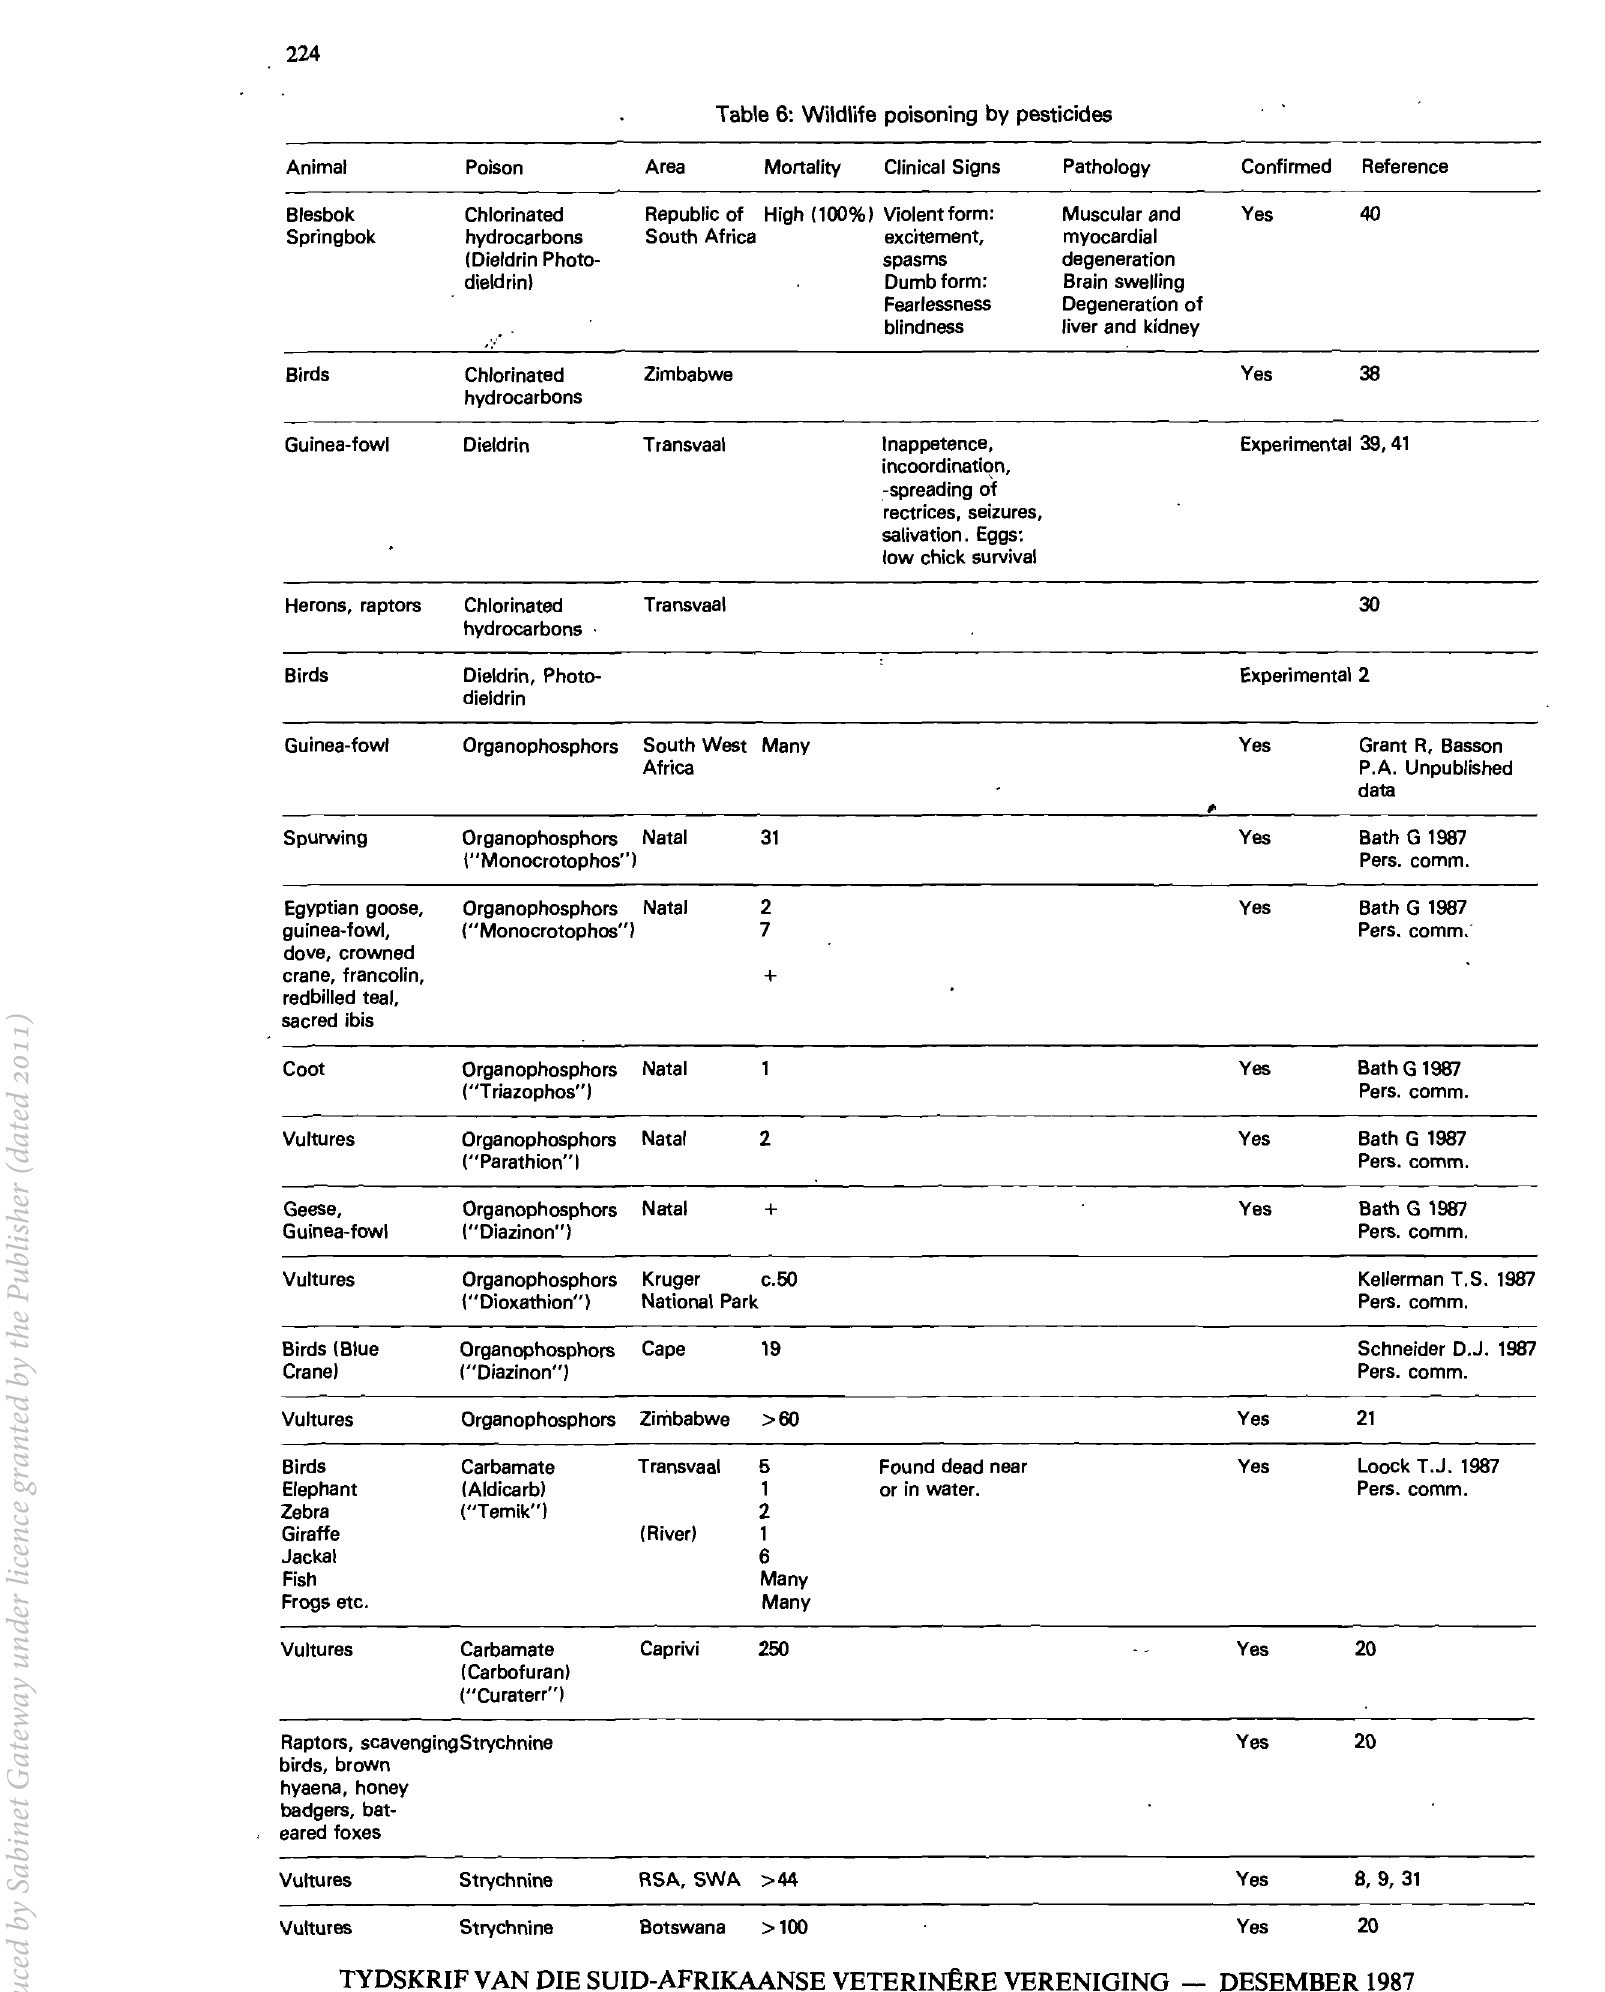
Table 6: Wildlife poisoning by pesticides Area Mortality Clinical